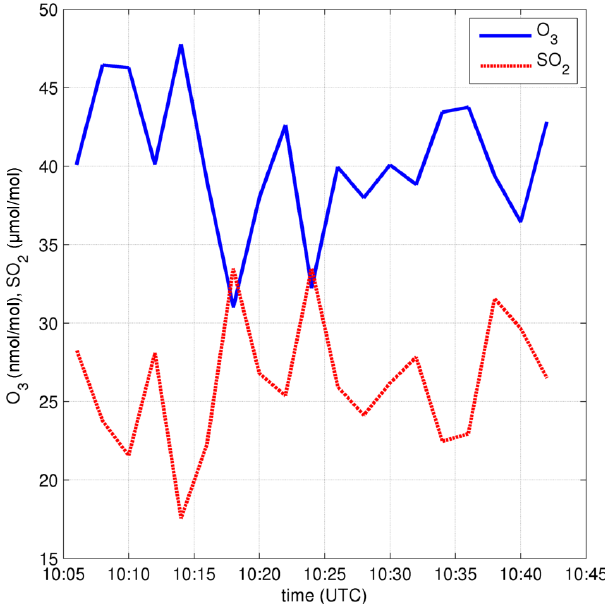
Figure 2. An example time series of measurements: O 3 and SO 2 mixing ratios measured in the plume at site d1-27. Data have been averaged into 120s bins as described in the